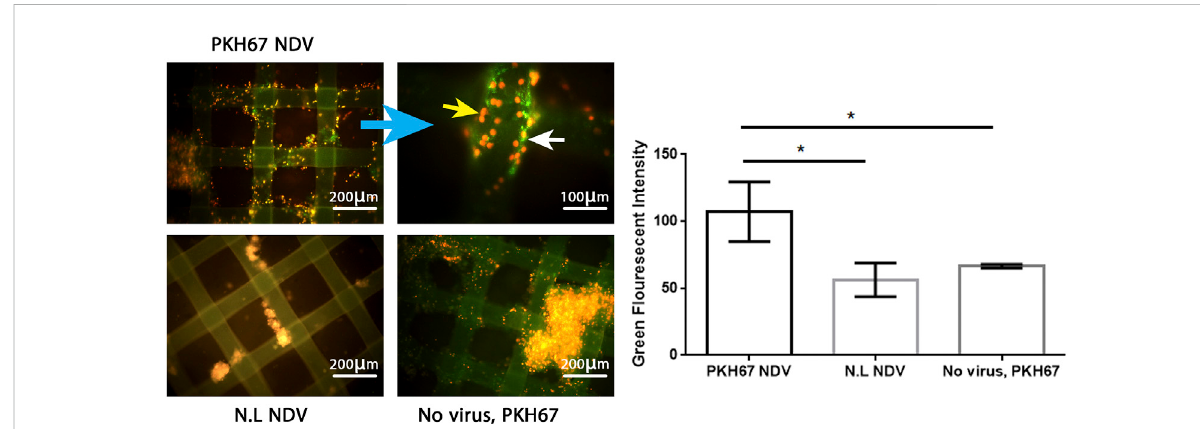
Infectivity analysis of PKH67-NDV in AMJ13-hATMSCs 3D spheroids. In representative fl uorescent images of the 3D coculture of AMJ13- hATMSCsinthe(3D)scaffoldsystem,spheroidswereinfectedatanMOIof10intheimagelabeledwithPKH67-NDV.Cellswereinfectedwithlabeled NDV (virus-carrying PKH67 linker). At 24 h post-infection, coculture spheroids were fi xed and propidium iodide (PI) – stained for nuclear staining. PI stainingisseenasred/orange,whilethecytoplasmisseenascleargreen fl uorescence,ensuringtheentryofthelabeledNDV.Thetopleft fi gure shows images of AMJ13 coculture (×100), and the top right fi gure shows the magni fi ed PKH67-NDV – infected spheroids (×400). While the fi gure on the bottom left shows an image of non-labeled NDV infecting the 3D coculture system, showing lysed and small spheroids stained only with red- orange propidium iodide dye. The picture at the bottom right presents coculture spheroids of the AMJ13 spheroid cells treated with PKH67 linker onlywithoutanyvirus (mock-infected) as thesecond control.While thehistogram clari fi esthe intensity of PKH67 green fl uorescence,revealingthat PKH67-NDV – infected spheres are the ones showing the most intense green fl uorescence.